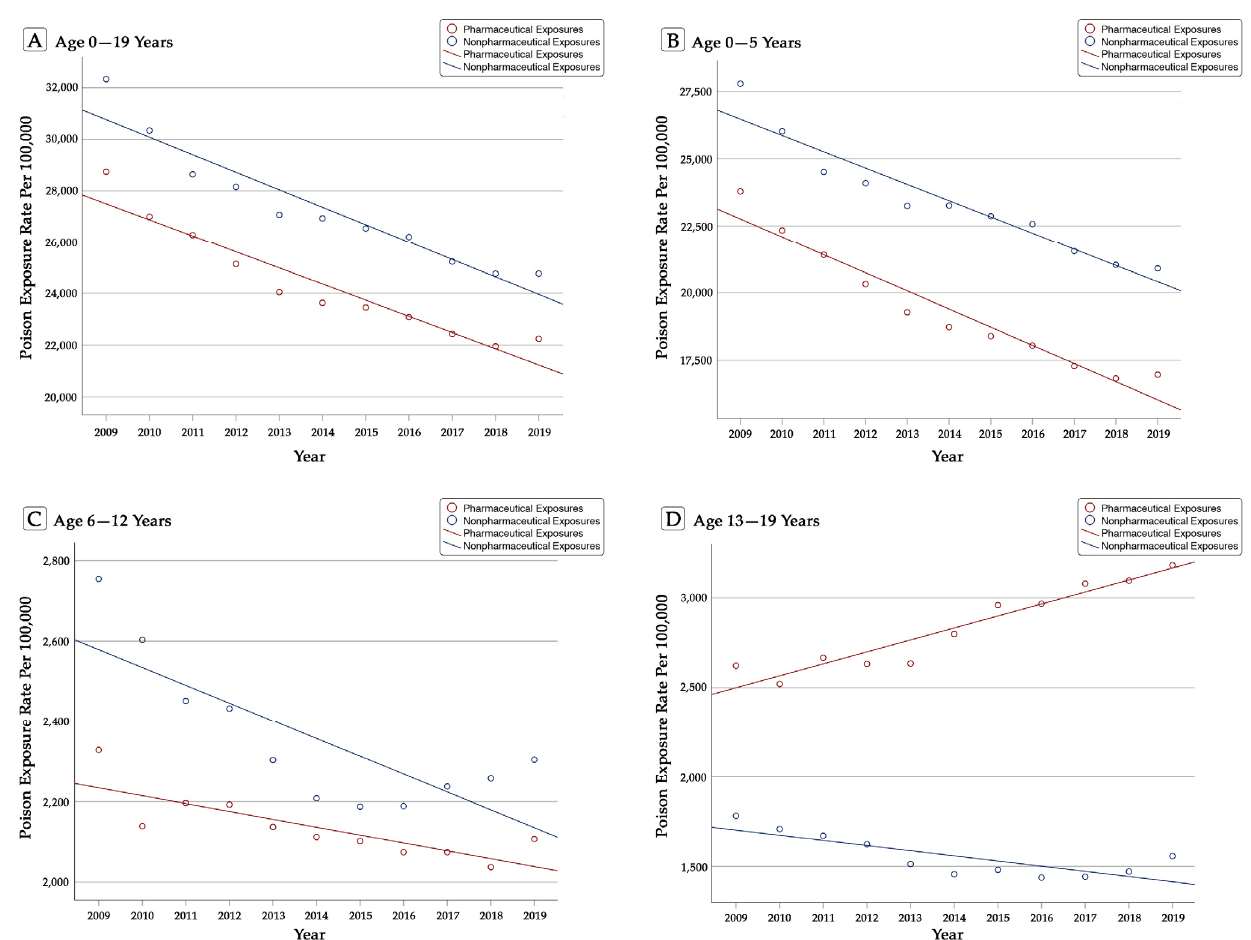
Figure 1. Linear Trends in Population-Adjusted Poison Exposures in U.S. Children,